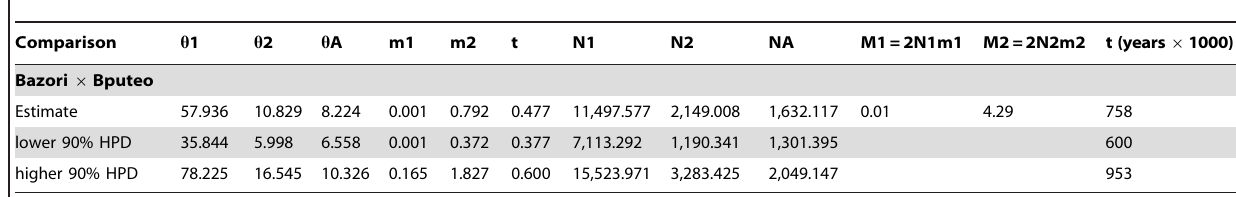
Table 4. Estimates and the 90% Highest Posterior Density (HPD) Intervals of Demographic Parameters from IMa multi locus